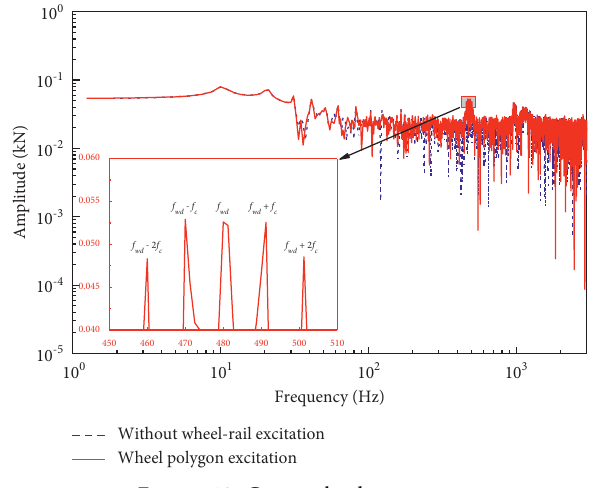
Figure 13: Contact load spectrum.